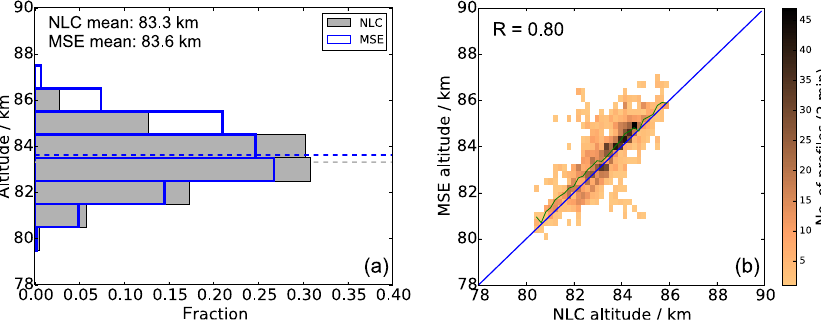
Figure 4. Same as Fig. 3, but for the layer maxima ( z max